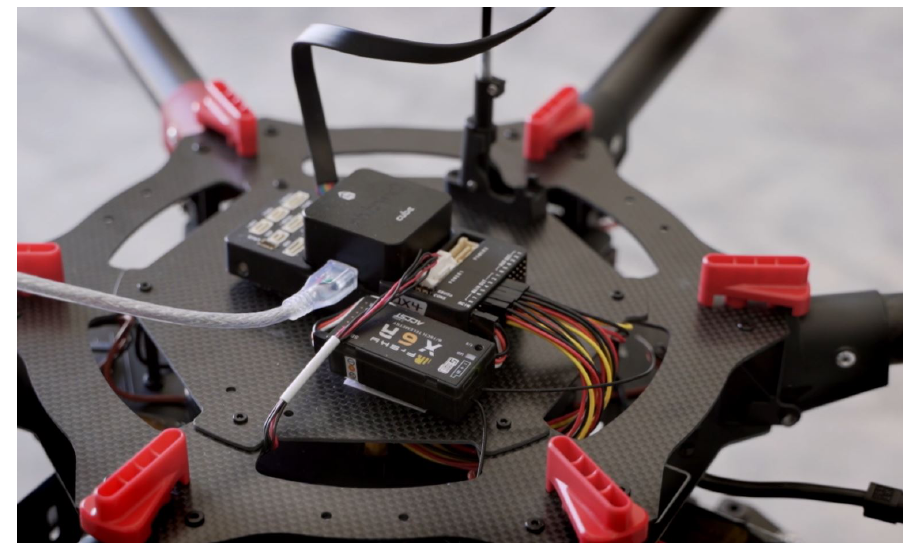
Figure 3. PixHawk autopilot.